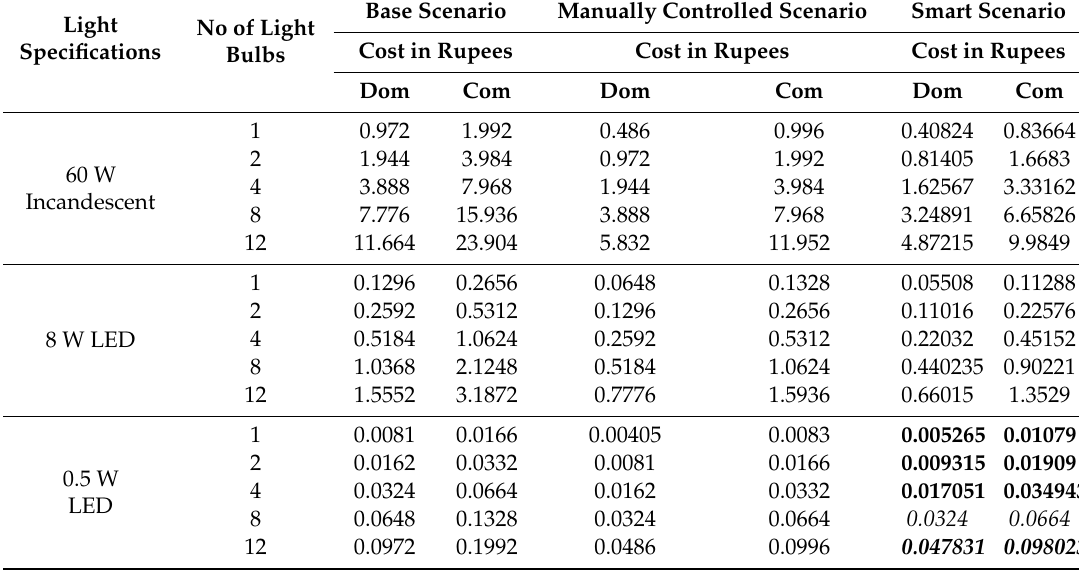
Table 12. Cost consumption analysis of light bulbs under diverse conditions and